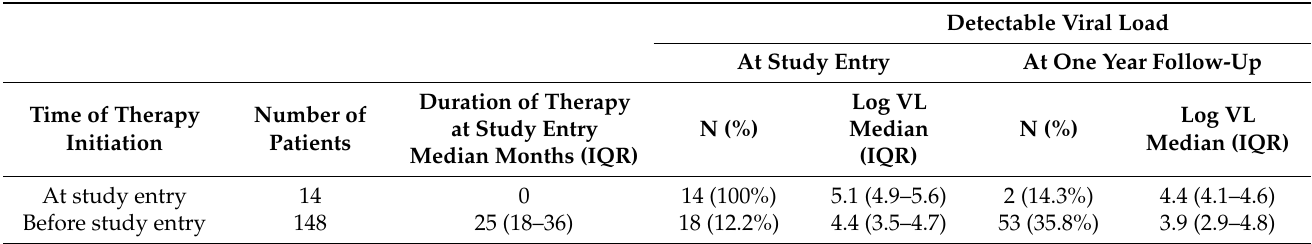
Table 2. Viral load among study patients, listed according to therapy experience for 162 patients with both study baseline and follow-up viral load pair.